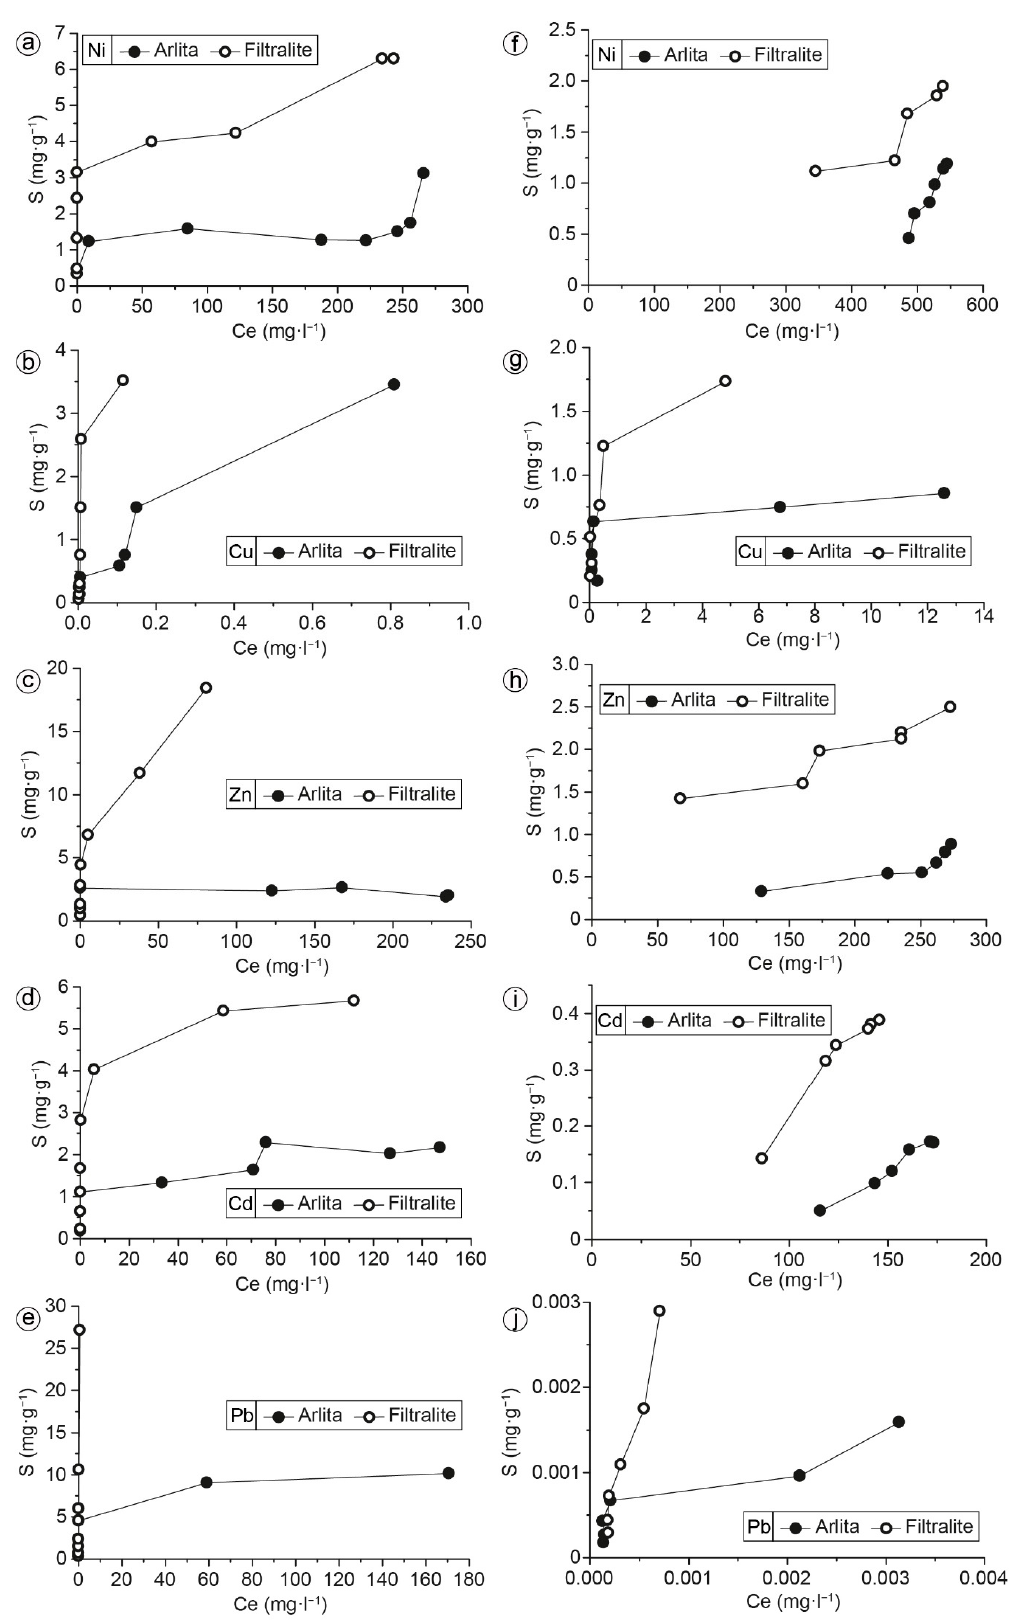
Figure 2. Adsorption isotherms of heavy metals for each contaminant obtained from solutions with individual contaminants ( a – e ) and from multielemental solutions ( f – j